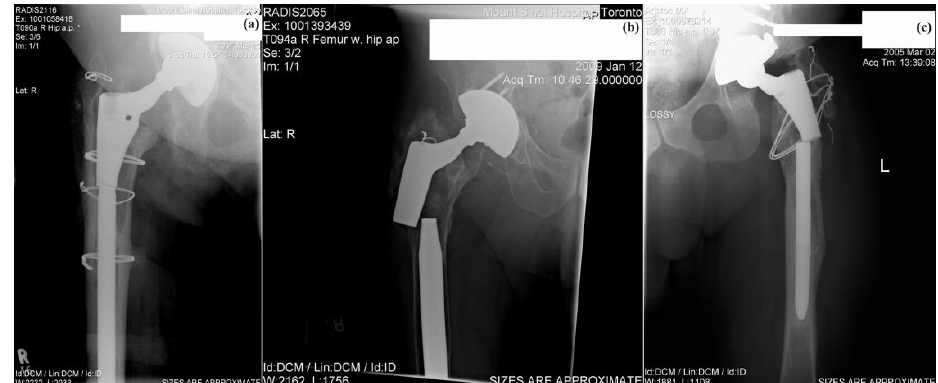
Figure 19. Radiographs revealing the fractures in vivo of cementless femoral stems in three humans ( a , b and c ) represent cases 1, 2 and 6, respectively, in Table I in Ref. [266]). The failures were initiated by a fretting fatigue mechanism and propagated via pure bending fatigue [266]. Reprinted with permission from Wolters Kluwer Health, Inc.